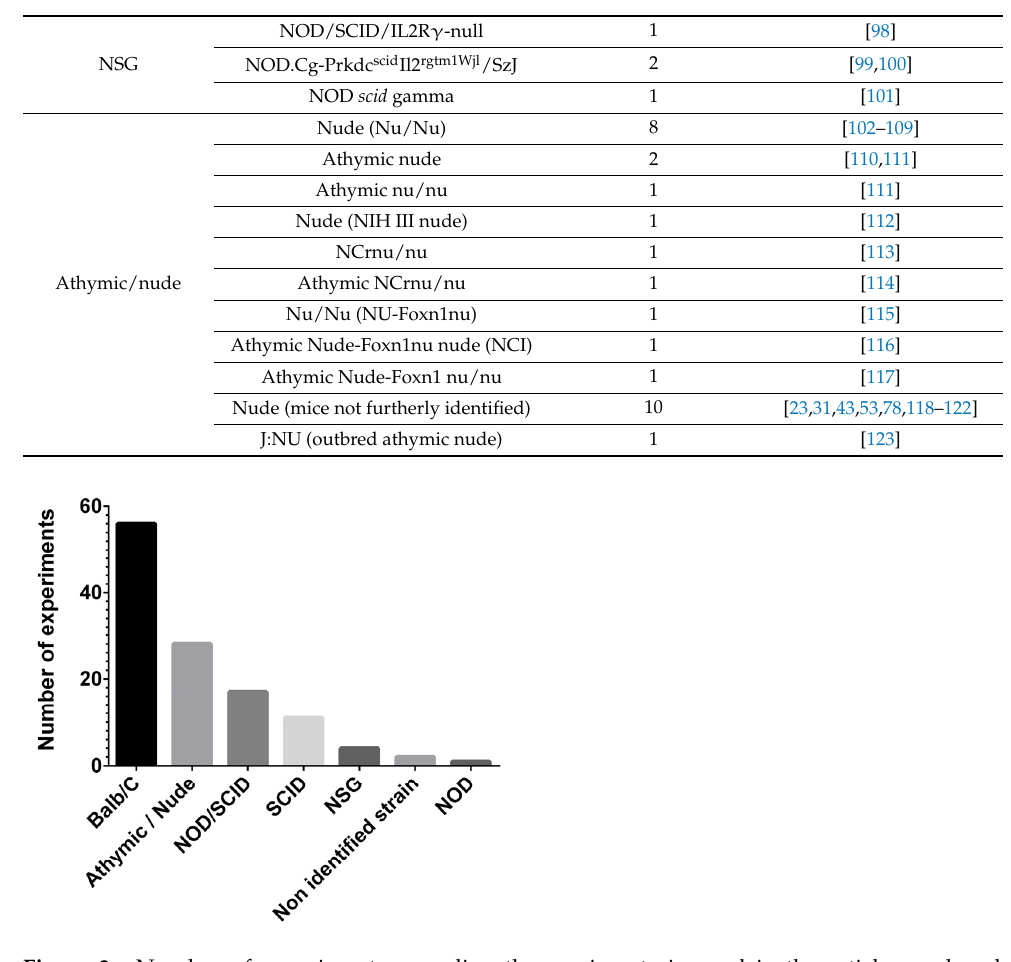
Figure 3. The absolute number of experiments regarding the cell lines, BrCSCs and PDX used to generate animal mice models. BrCSCs: breast cancer stem cells; PDX: patient-derived xenograft; and T47D-TR: tamoxifen-resistant.